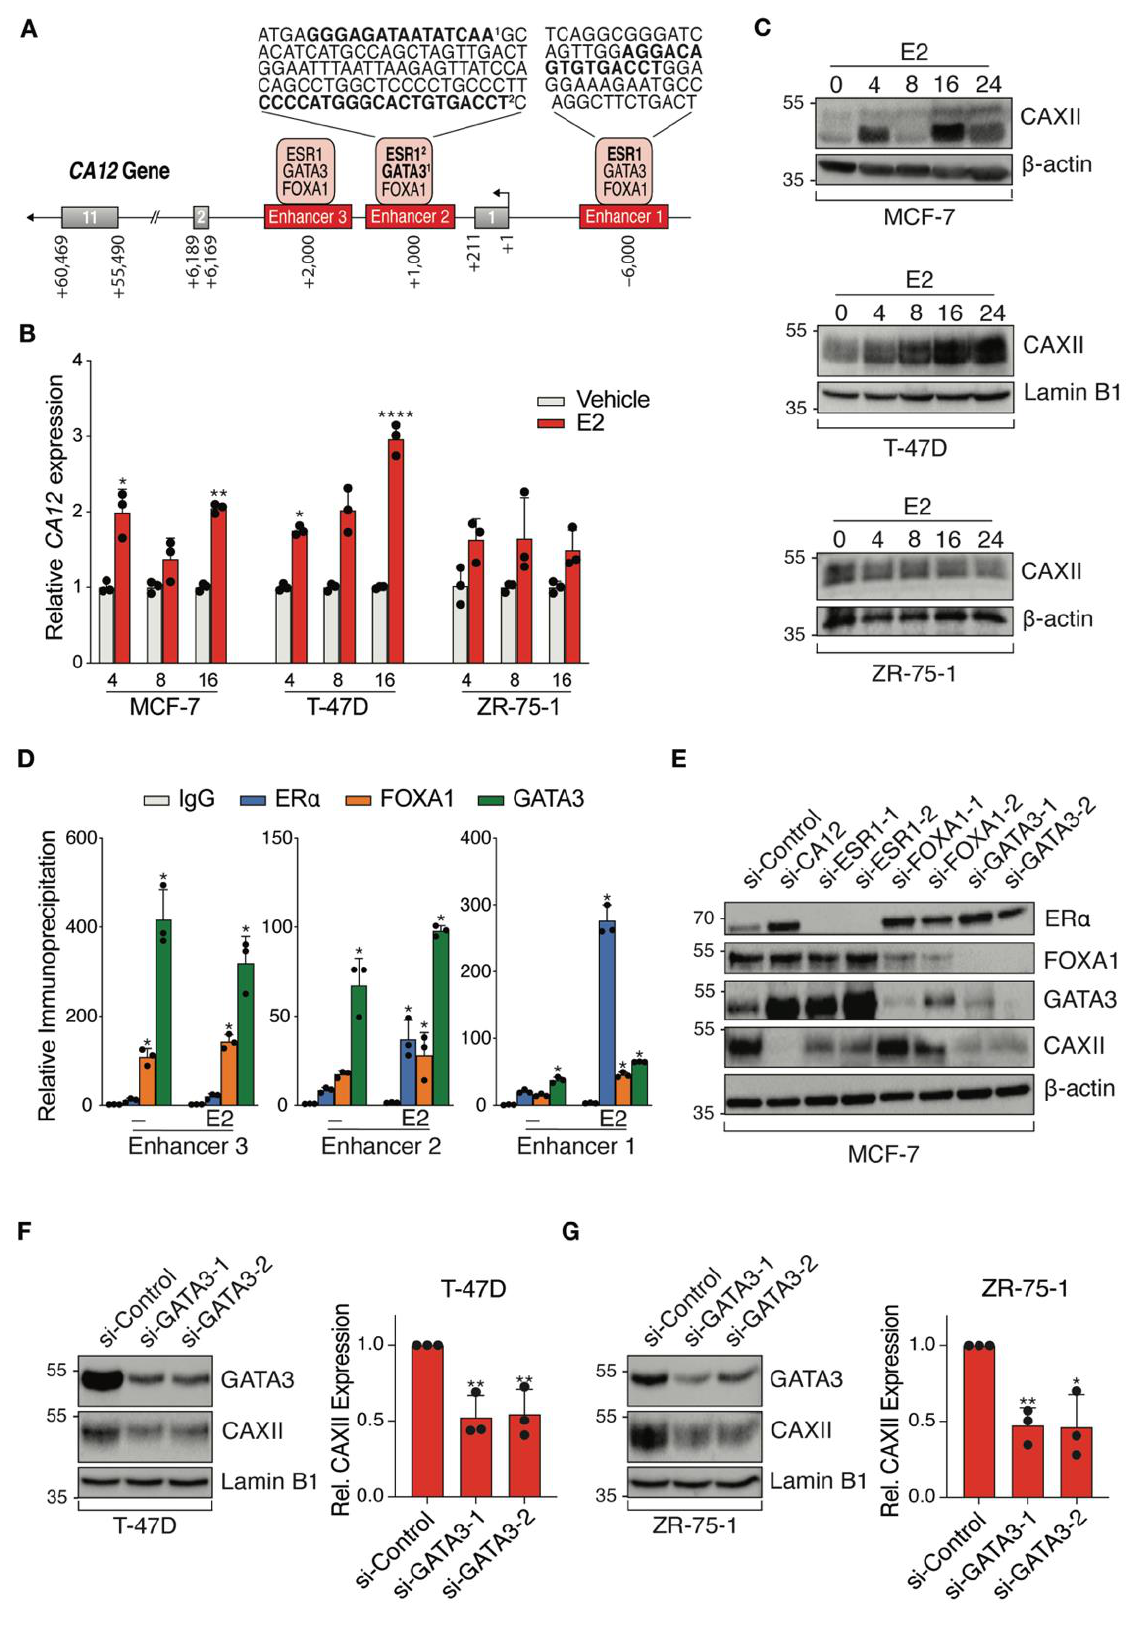
Figure 4. ER α and GATA3 positively regulate CA12 expression in luminal breast cancer cell lines. ( A ) Schematic CA12 gene organization with exons (grey boxes) and putative enhancers (red boxes). Predicted binding motifs for ERα and GATA3 are highlighted in bold in sequences for enhancers 1 and 2. ( B ) MCF-7, T-47D and ZR-75-1 cell lines were cultured in hormone-depleted medium for five days and then treated with E2 (25 nM). CA12 mRNA levels were measured by RT-qPCR at 4, 8 and